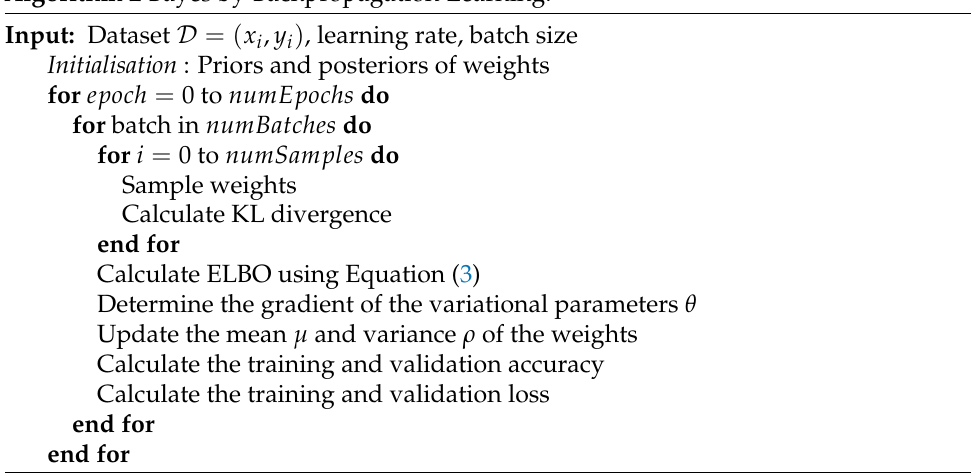
Algorithm 2 Bayes by Backpropagation Learning.